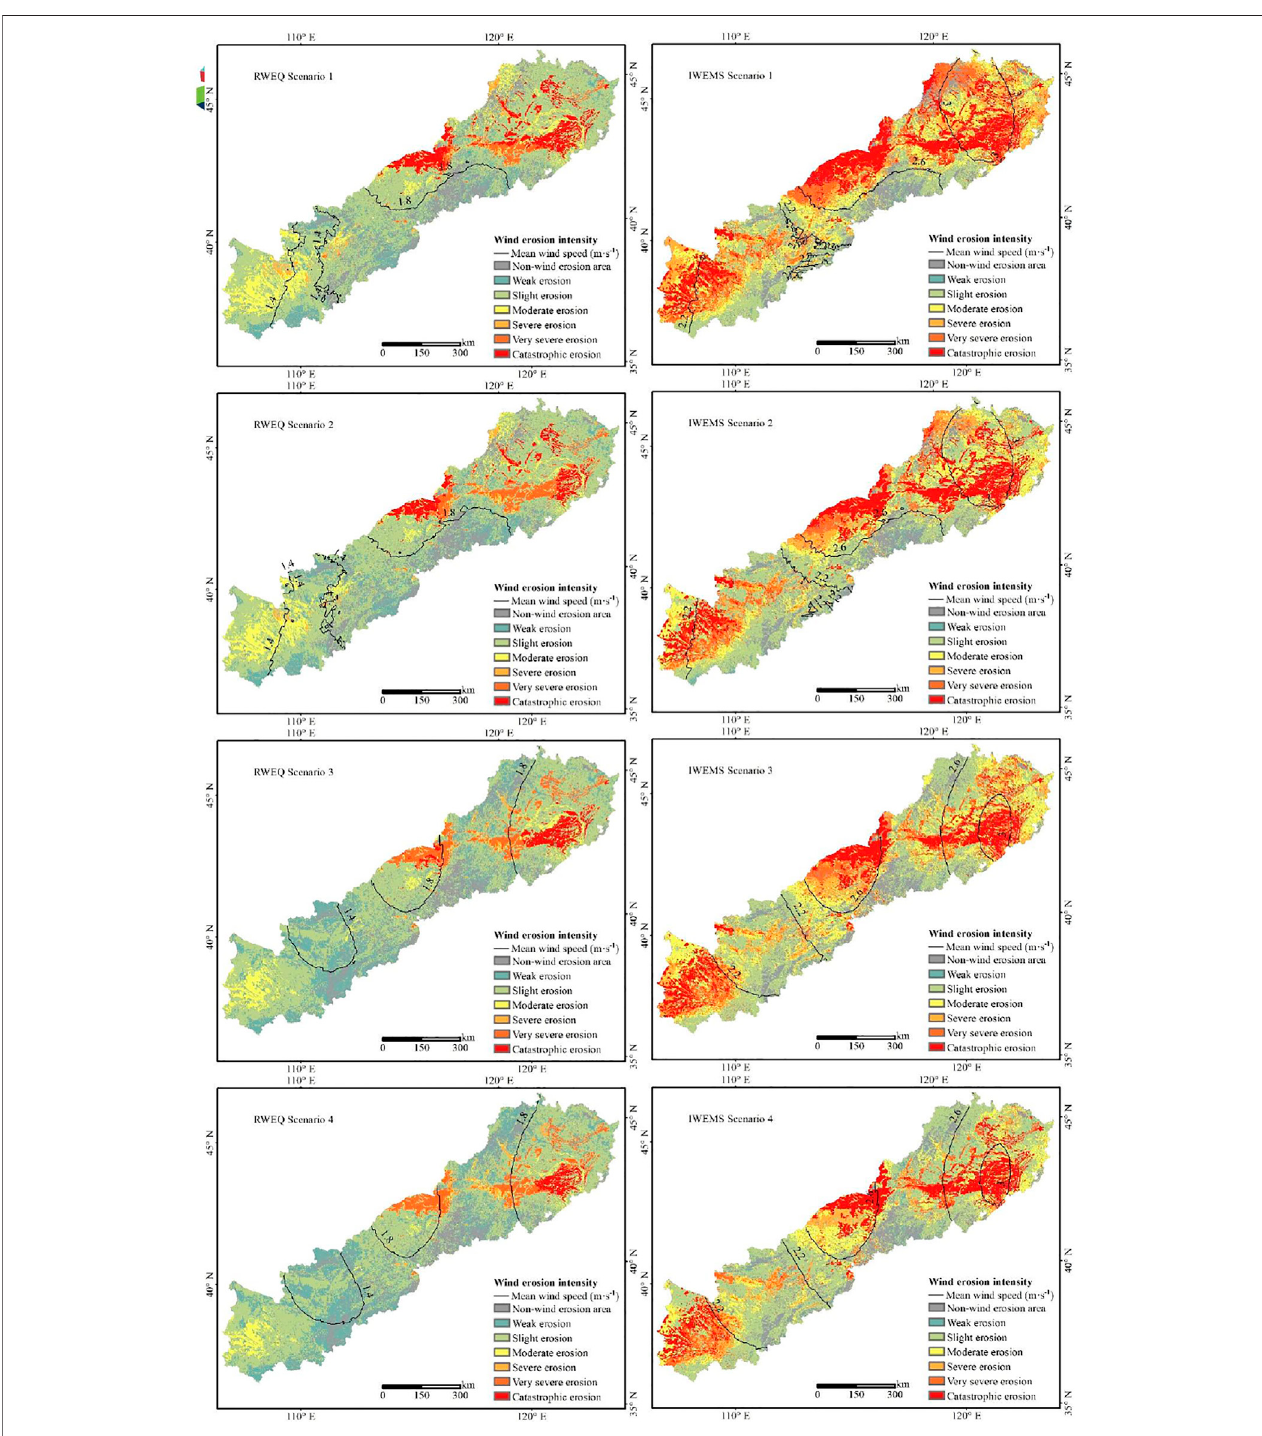
FIGURE3| Spatialdistributionofthewinderosionhazardsforthedifferentscenarios.Note:MeanwindspeedinRWEQat2 mheightandinIWEMSat10 mheight.